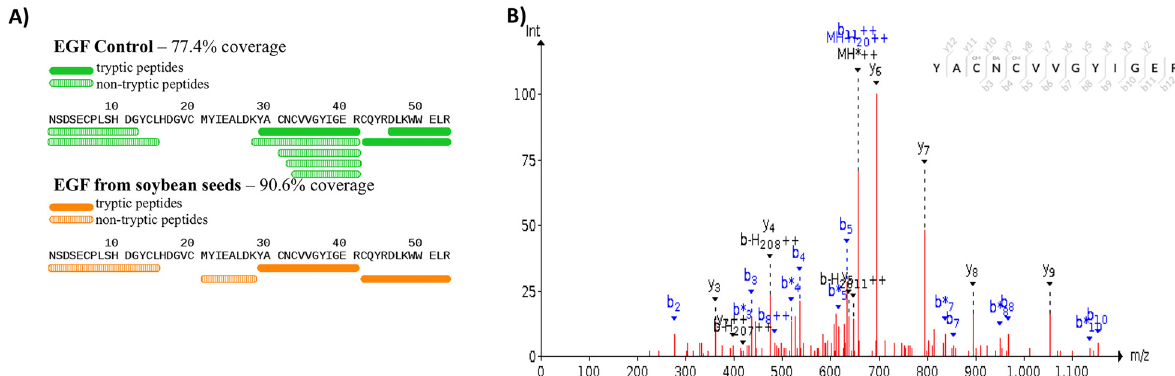
Fig 4. Mass spectroscopy data to detect the presence of EGF peptides in transgenic EGF soybean seeds. (A) Coverage of peptides detected in both commercially available EGF (green) and from transgenic soybean seeds (orange) using both trypsin (solid) and non-trypsin peptides (hatched). (B) Raw spectra data depicting the amino acid sequence CNCVVGYUGER detected from a low molecular weight enriched soluble dry seed protein extract from EGF transgenic soybean.